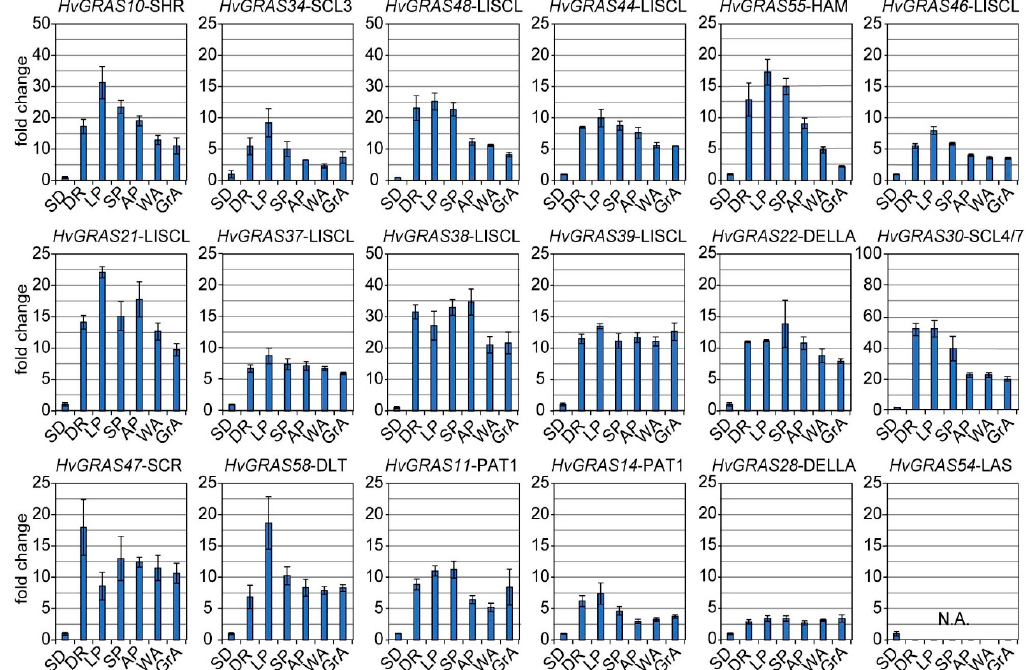
Figure 5. Relative transcript abundance of 18 genes in barley inflorescence (Golden Promise cultivar) developmental stage. qRT-PCR generates the RNA level in spike development including double-ridge (DR), lemma primordium (LP), stamen primordium (SP), awn primordium (AP), white anther (WA), green anther (GrA). Two-week-old seedling as a control. Bars indicate SD of three technical replicates.